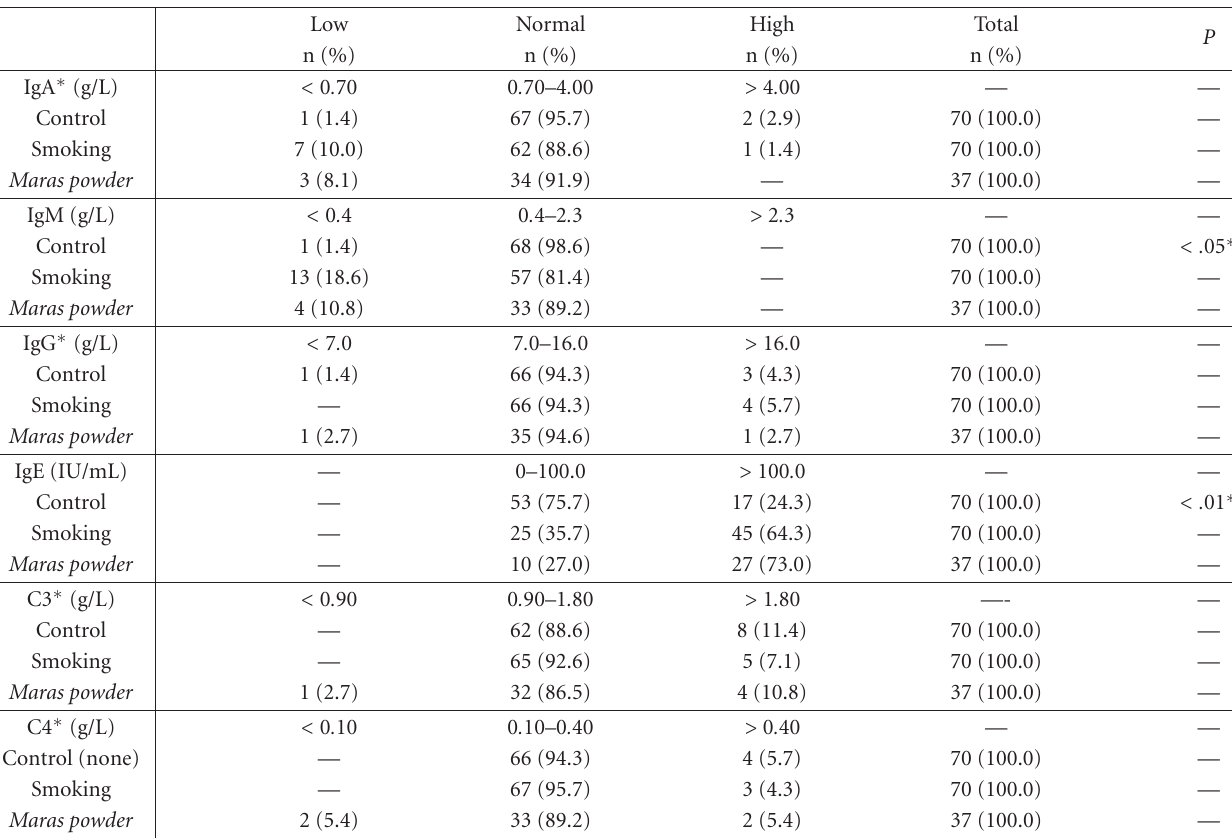
Table 2: Distribution of the humoral immune system parameters with respect to low, normal, and high ranges in study groups. Low